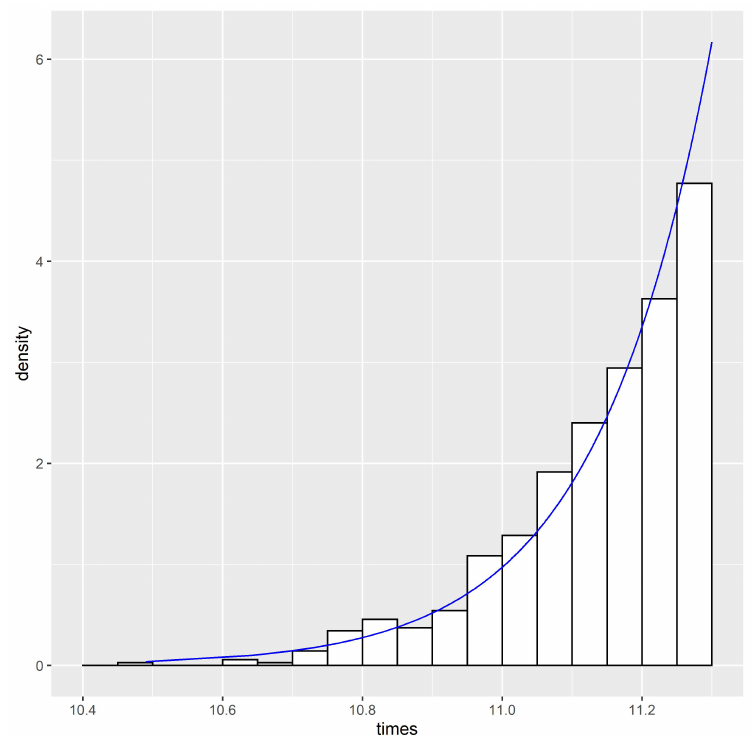
Figure 4. Histogram of the results of women’s 100 m faster than 11.3 s and pdf of the power function distribution with λ = 11.3 and β = 69.73, where the latter is the maximum likelihood estimate based on all times below 11.3 as upper threshold.